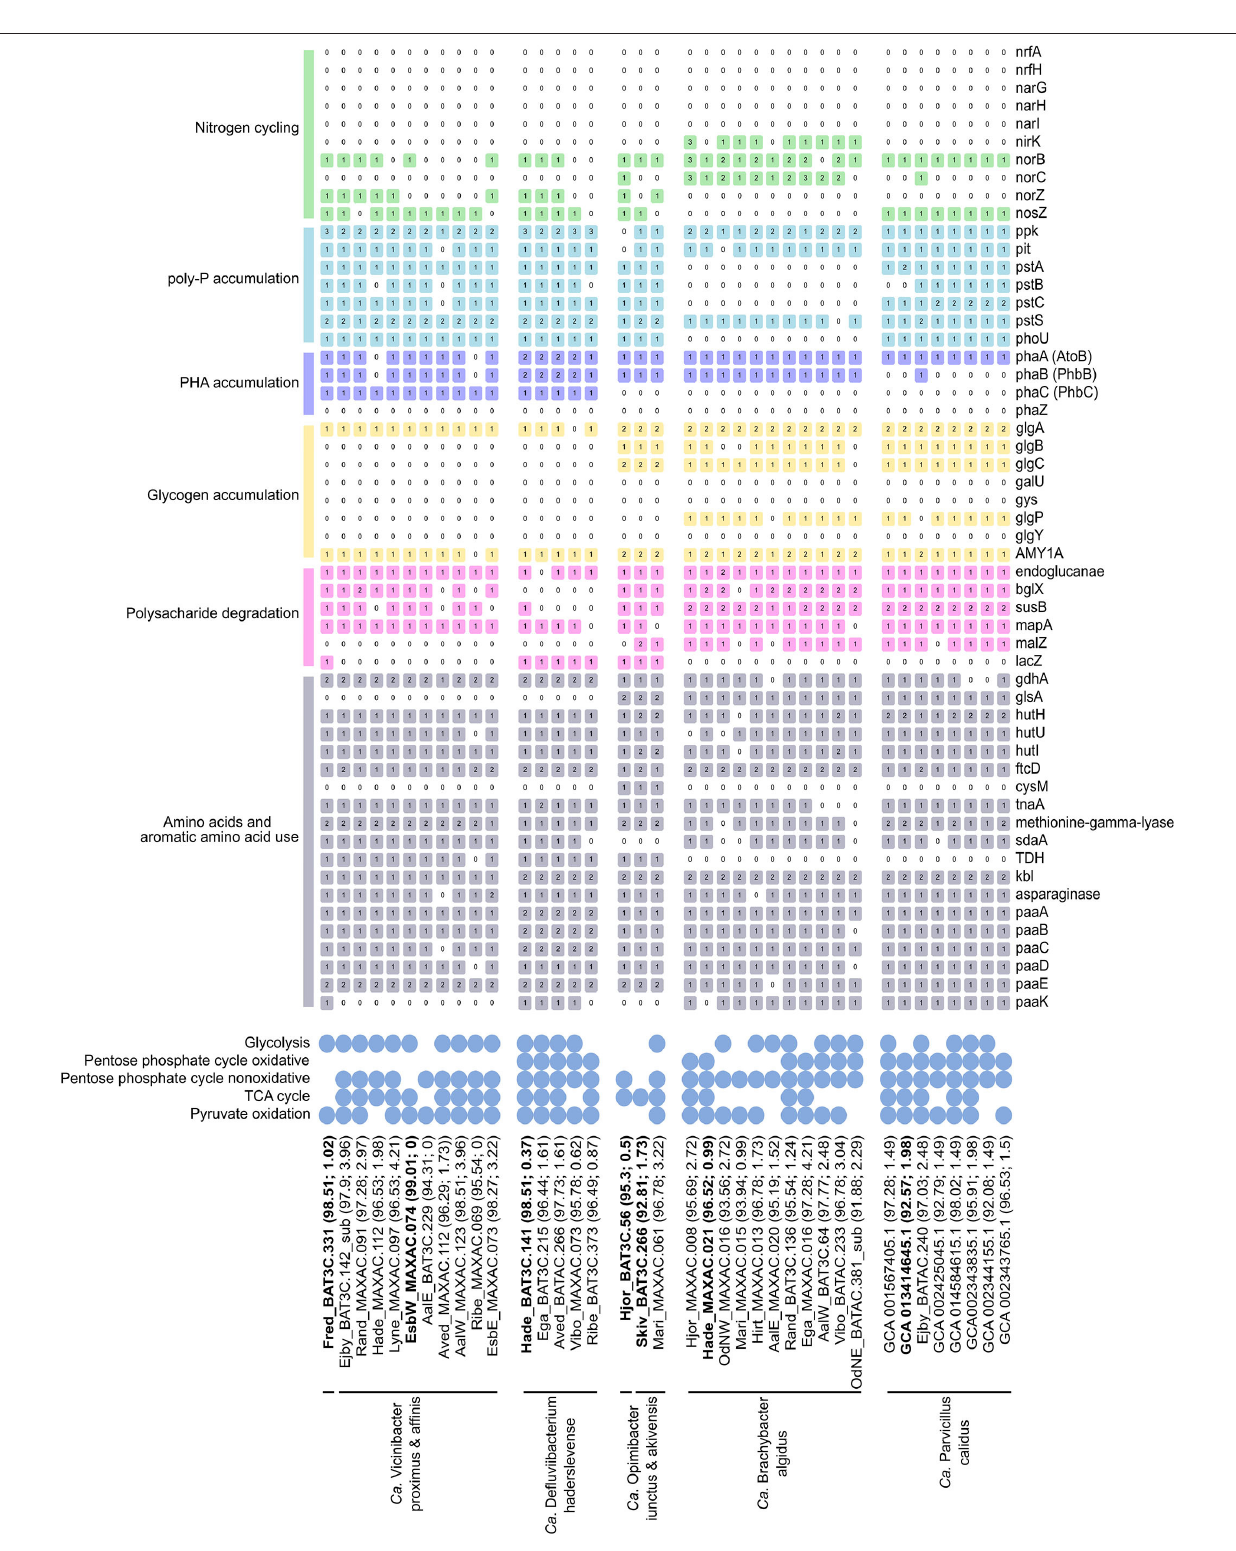
Frontiers in Microbiology |